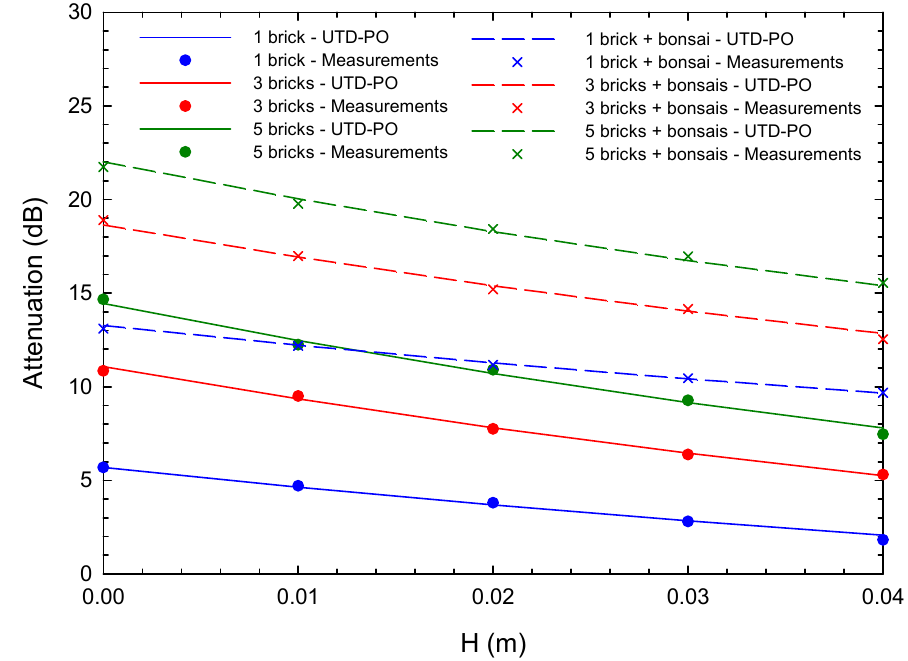
Figure 3. Comparison of the attenuation obtained with the UTD-PO solutions for rectangular sections (with and without trees), as a function of H, and measurements. Parameters of f = 39 GHz, n = 1–3–5, d = 1 m, w = 69.9 cm, v = 5.1 cm, relative permittivity of the bricks ε r = 4.37 + 0.04j, Δ d = 9 cm, hard/vertical polarization, and the COST 235 foliage-attenuation model for the in-leaf case have been considered.